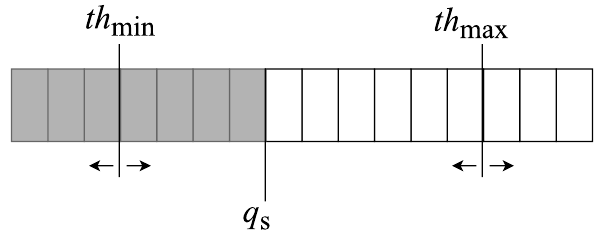
Figure 3. Threshold levels within a queue-buffer for RED.